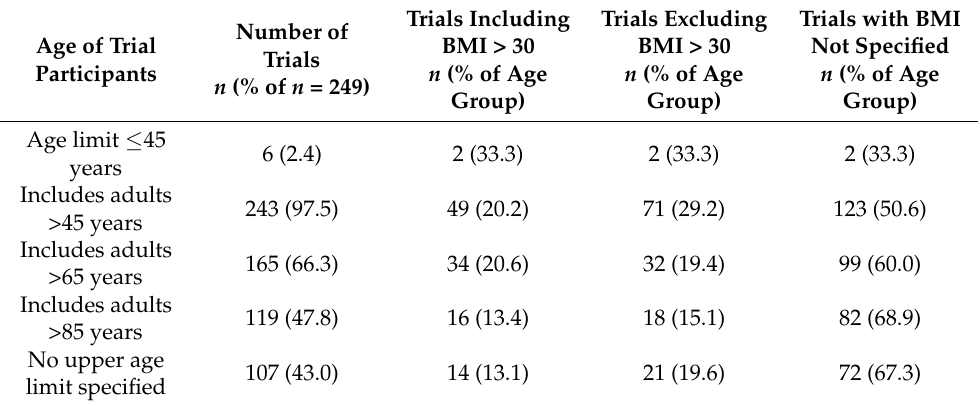
Table 5. BMI >30 inclusion and exclusion by age of participants in COVID-19 vaccine